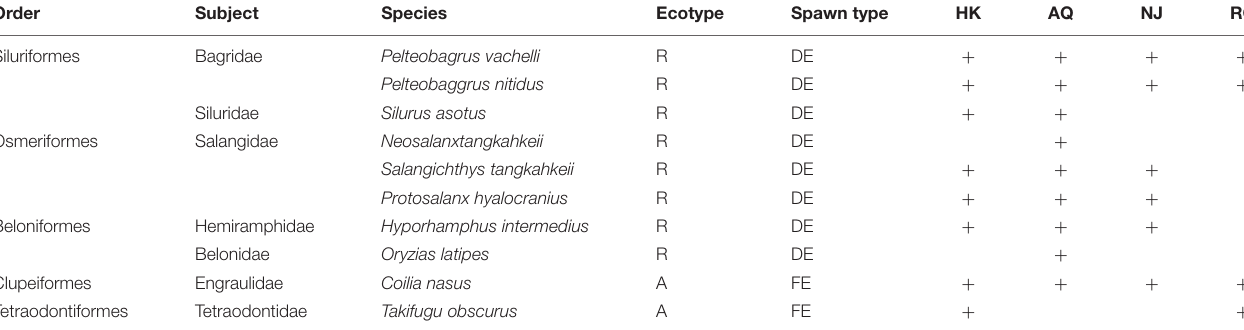
TABLE 2 | Species quantity and percentage of ichthyoplankton distribution type.